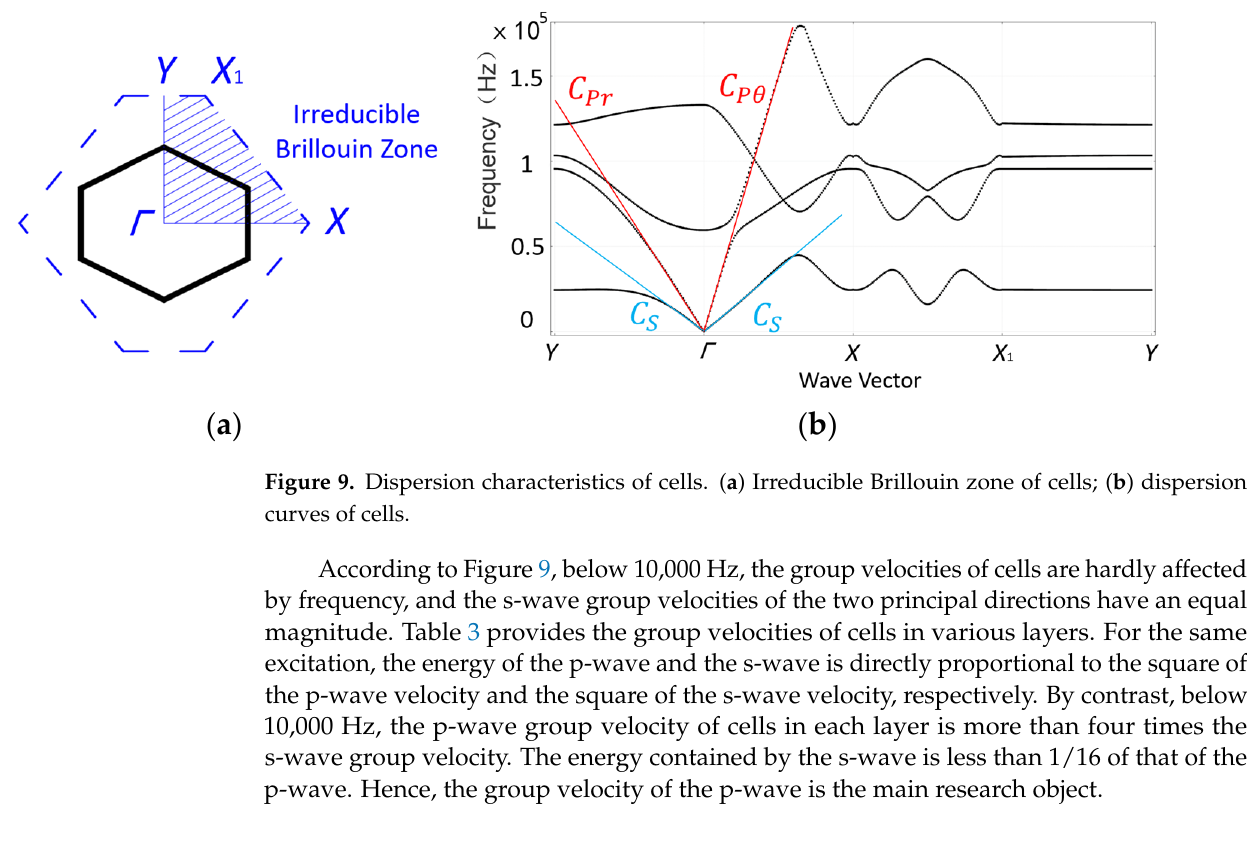
Table 3. Group velocities of cells for the pentamode lattice-ring structure.